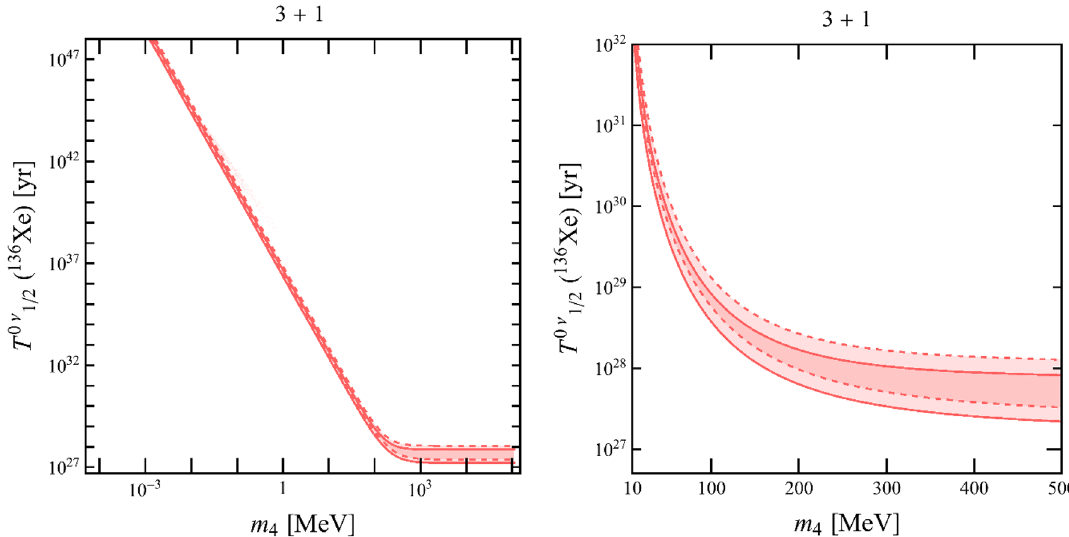
Figure 7 . 0 (cid:23)(cid:12)(cid:12) half-life of 136 Xe as a function of m 4 in the 3+1 model. We show results obtained with the QRPA (solid) or Shell Model (dashed) NMEs. The bands re(cid:13)ect the uncertainty due to LECs associated with hard-neutrino exchange. Right-panel: same as left panel but for neutrino masses around the pion